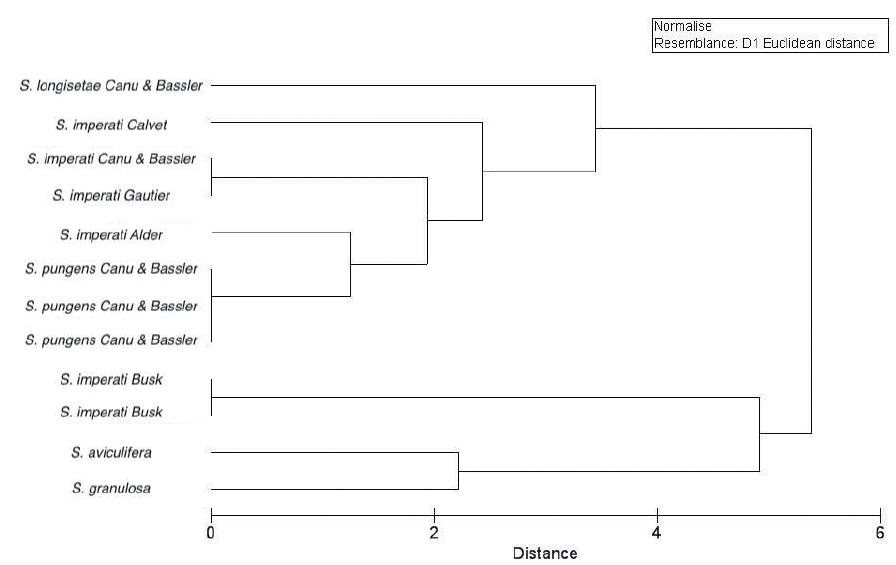
Fig. 2. Dendrogram on qualitative characters (frontal shield surface; frequency of frontal pores; peristome shape; frequency of adventitious avicularia, abfrontal vicarious avicularia, abfrontal oval adventitious avicularia and abfrontal triangular adventitious avicularia; abfrontal surface; ovicell shape) of the species that constitute the imperati -group: S. aviculifera (Canu & Bassler, 1930), S. granulosa (Canu & Bassler, 1930), S. imperati (Busk, 1884), S. imperati from other authors, S. longisetae (Canu & Bassler, 1928) and S. pungens (Canu & Bassler, 1925). Schizoretepora “imperati” sensu O’Donoghue & de Watteville 1939 has been excluded from the analysis because it lacks